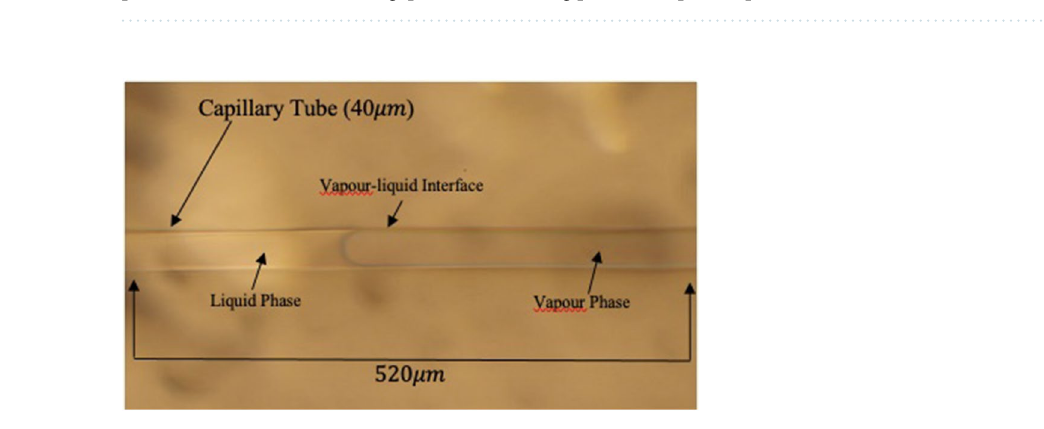
Figure 3. ( a ) Pressure at each stage in 0.04 and 0.13 mm gap thickness during pressure build-up process; ( b ) pressure in 0.04 and 0.13 mm gap thickness during pressure depletion process.